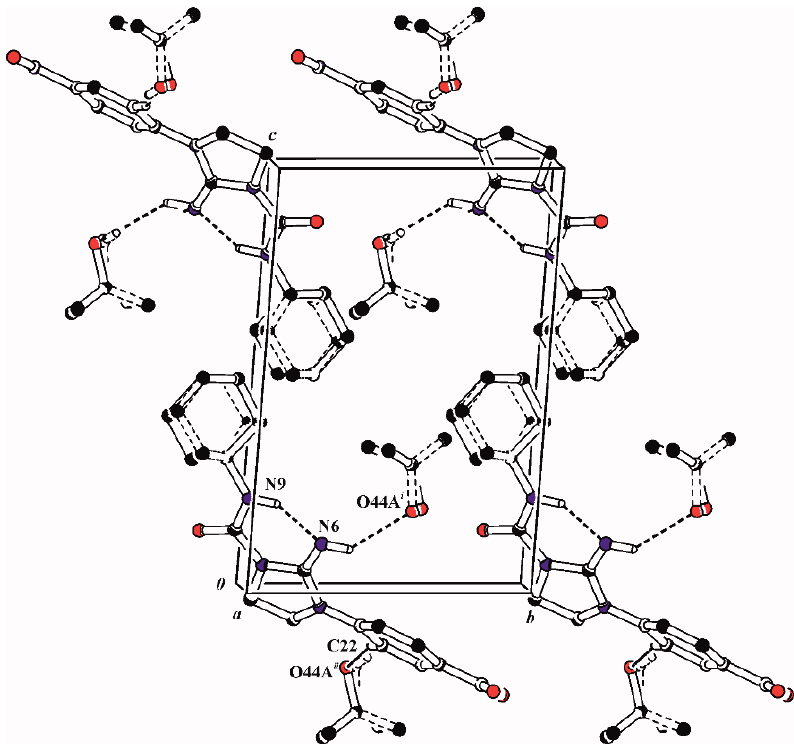
Figure 3. Unit-cell packing of the compound 4f . H atoms not involved in hydrogen bonding have been excluded.